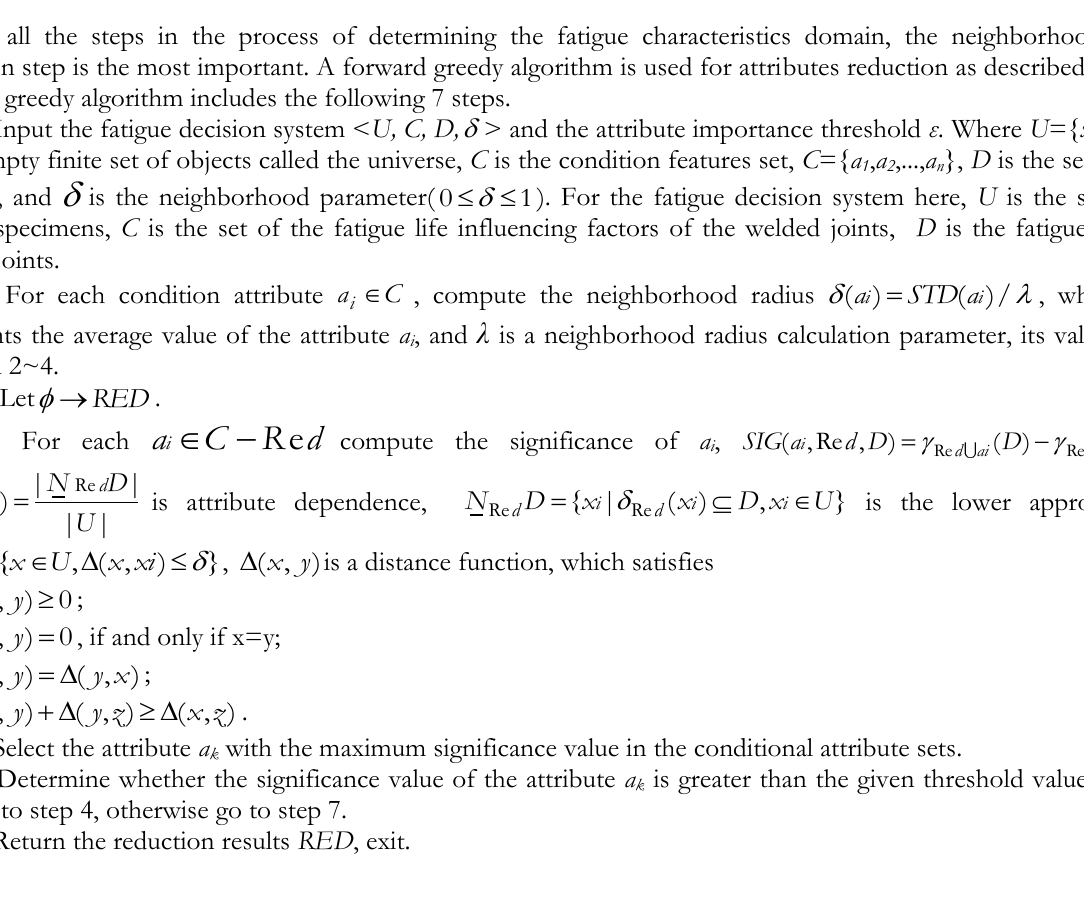
Figure 2: Process of determining of the fatigue characteristics